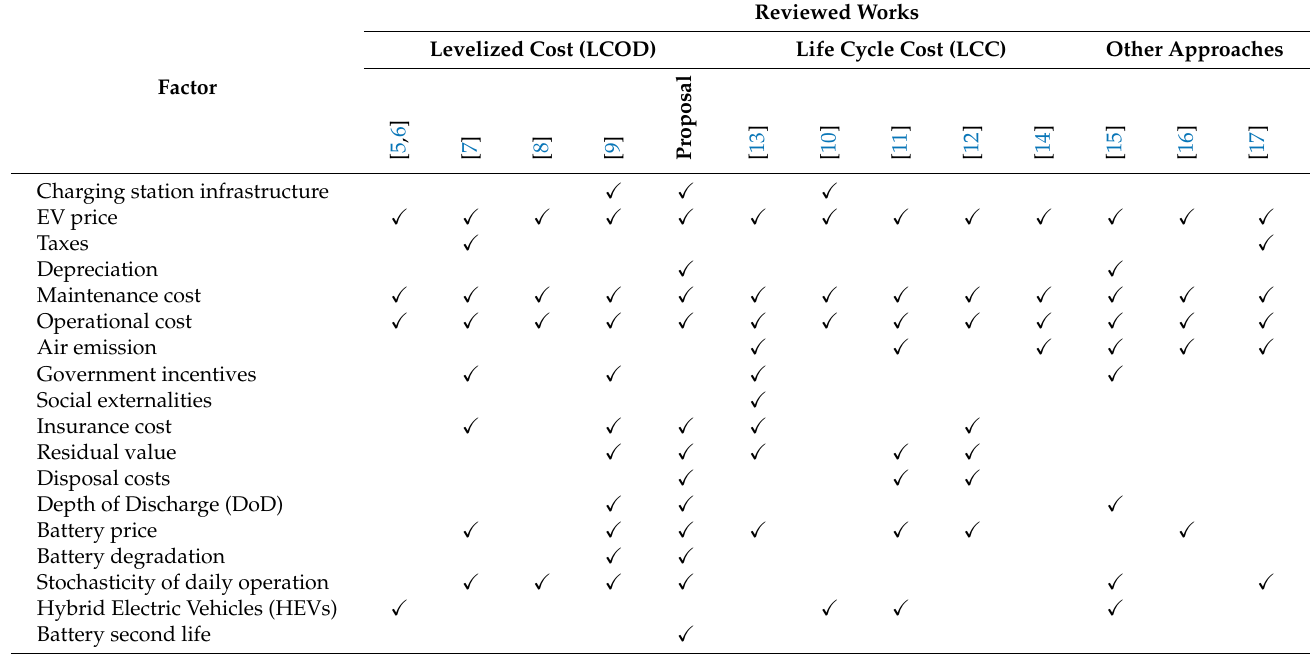
Table 1. Summary of the factors commonly considered for economic analyzes to evaluate electric